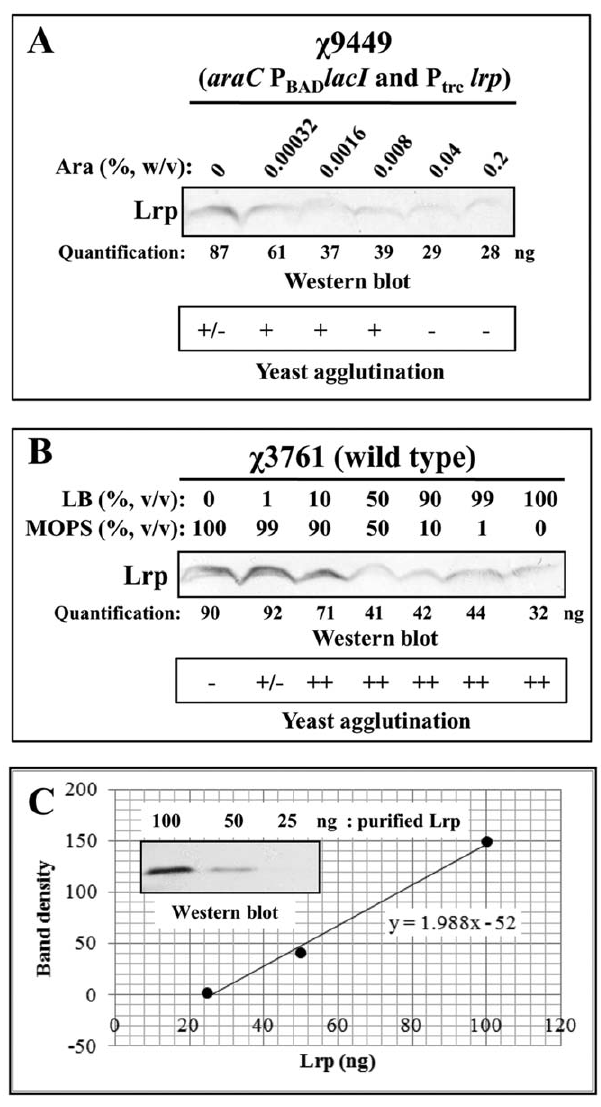
Figure 8. Effect of cellular Lrp levels on type 1 fimbriae production in S . Typhimurium. (A) Western blot analysis for Lrp synthesis and mannose-sensitive yeast agglutination assay for the type 1 fimbriation in strain x 9449 grown statically at 37 u C for 24 h in LB medium supplemented with various arabinose concentrations. (B) Western blot analysis for Lrp synthesis and mannose-sensitive yeast agglutination assay in the wild-type strain x 3761 grown statically in various combination of MOPS and LB media at 37 u C for 24 h. Agglutination was scored as follows: -, no; + /-, very weak; + , weak; and ++ , good. (C) Preparation of standard curve for quantification of cellular Lrp levels by western blot analysis of purified Lrp (100, 50, and 25 ng) using anti-Lrp antiserum and